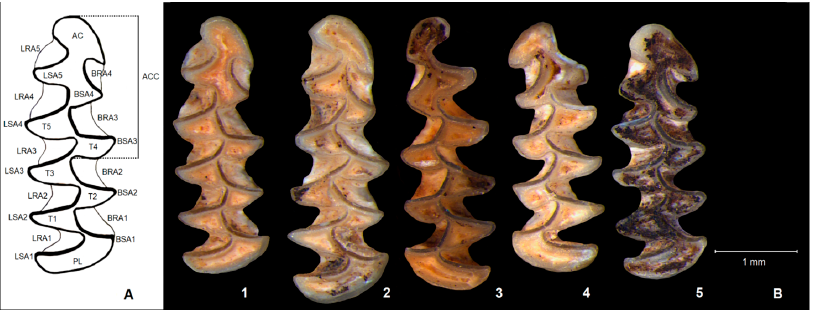
Figure 1. ( A ) dental nomenclature of Arvicolinae first lower molars (m1) (after Hibbard [13] and